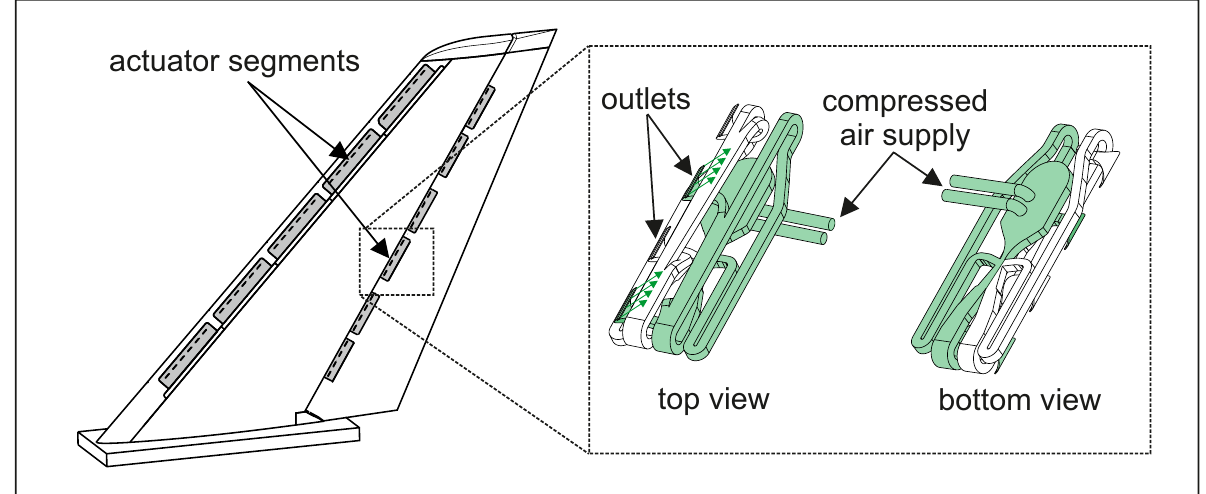
Figure 2. Sketch of the VTP wind-tunnel model with multiple FO-PJA